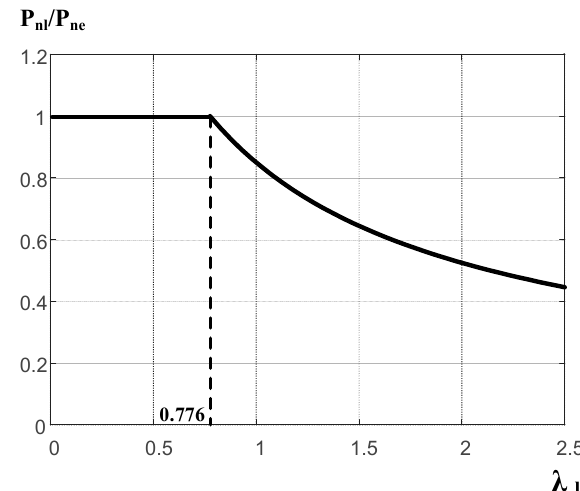
Figure 9. The interaction between global and local buckling strength.